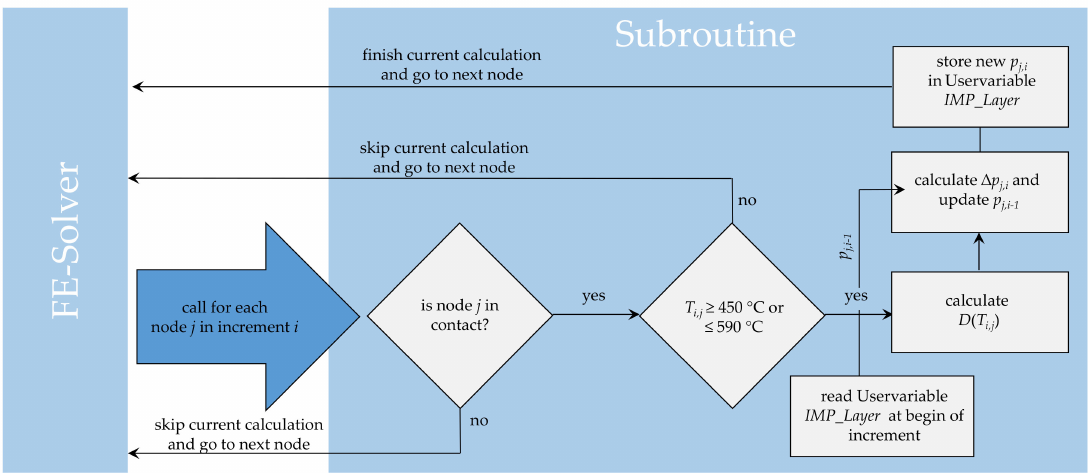
Figure 4. Flow chart for the developed subroutine that is executed for each node of the aluminum in each